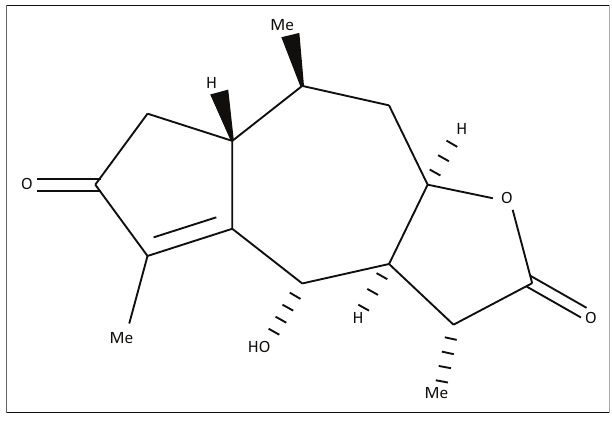
FIGURE 1: Geigerin, a sesquiterpene lactone, isolated from Geigeria aspera